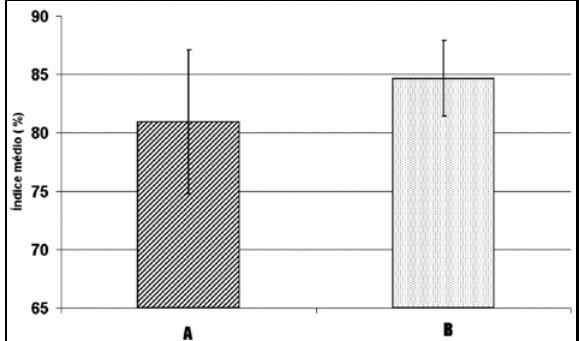
Figura 3 – A: Carcinomas basocelulares de padrão sólido; B: carcinomas basocelulares de padrão esclerodermiformes e micronodulares. Observou-se diferença estatística para TIMP-1 ( p = 0,04) entre A e